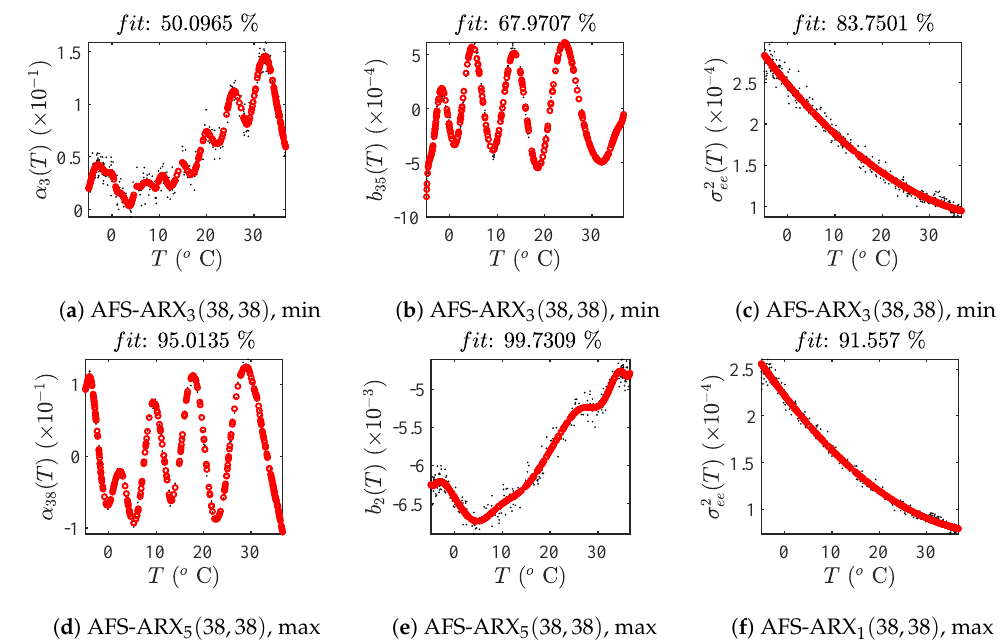
Figure 11. Spring-mass-damper: actual (black dots) and GPR-estimated (red circles) long time-scale parameter